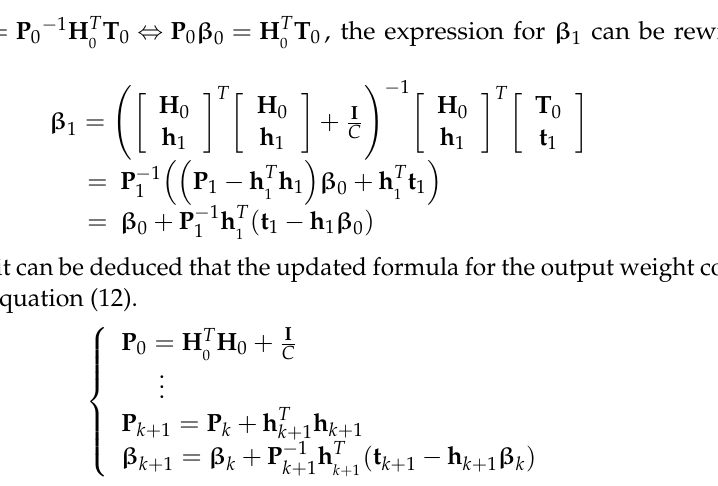
Figure 2. The flow chart of the proposed FOS_RELM.